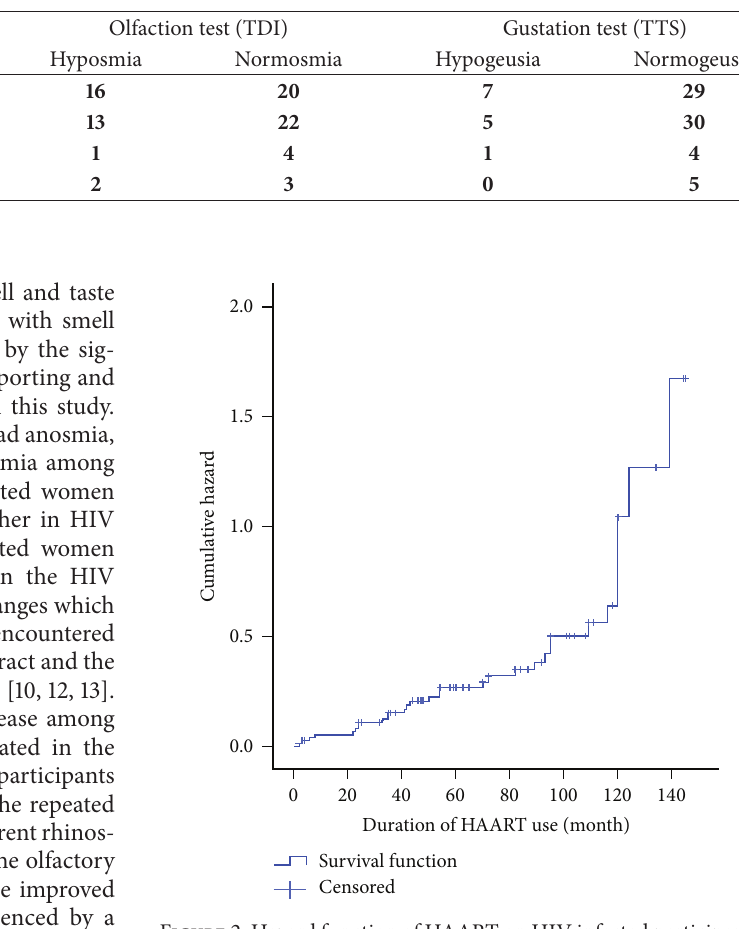
Figure 2: Hazard function of HAART on HIV infected participants with